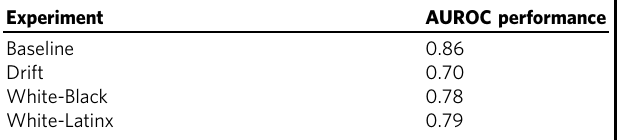
Table 5 AKI model: impact of drift and